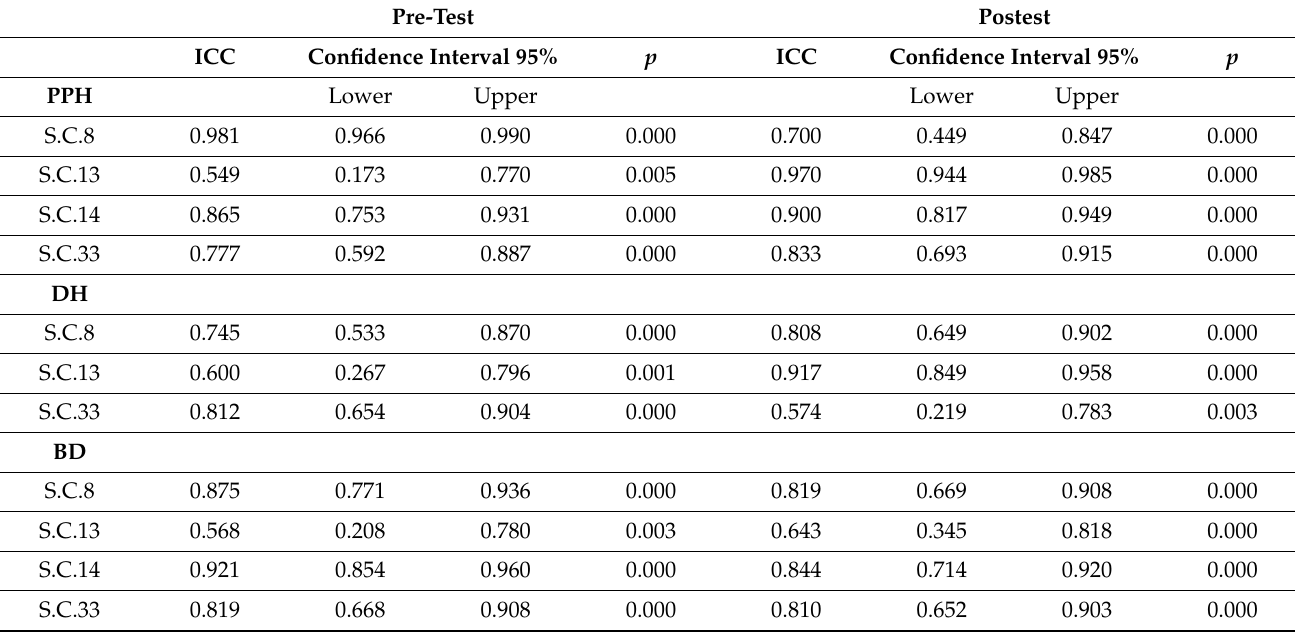
Table 6. Intra-class correlation coefficient for the different scenarios.